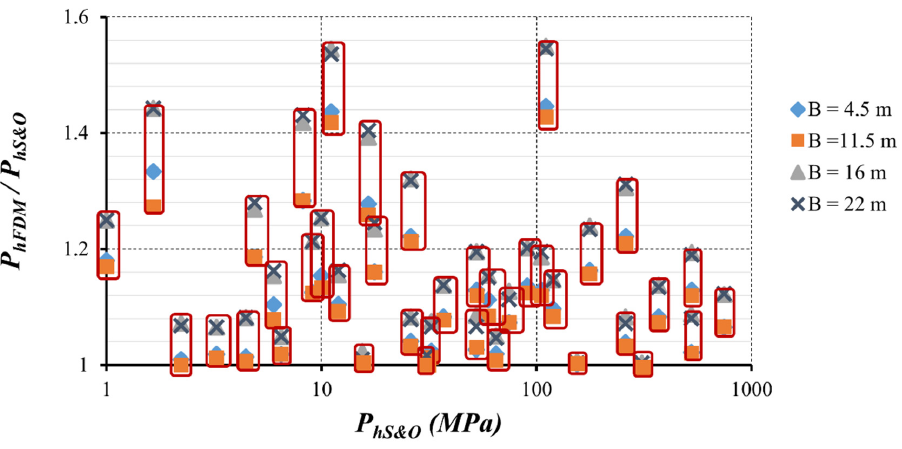
Figure 5. Relation between P hFDM and P hS&O depending on P hS&O and B .